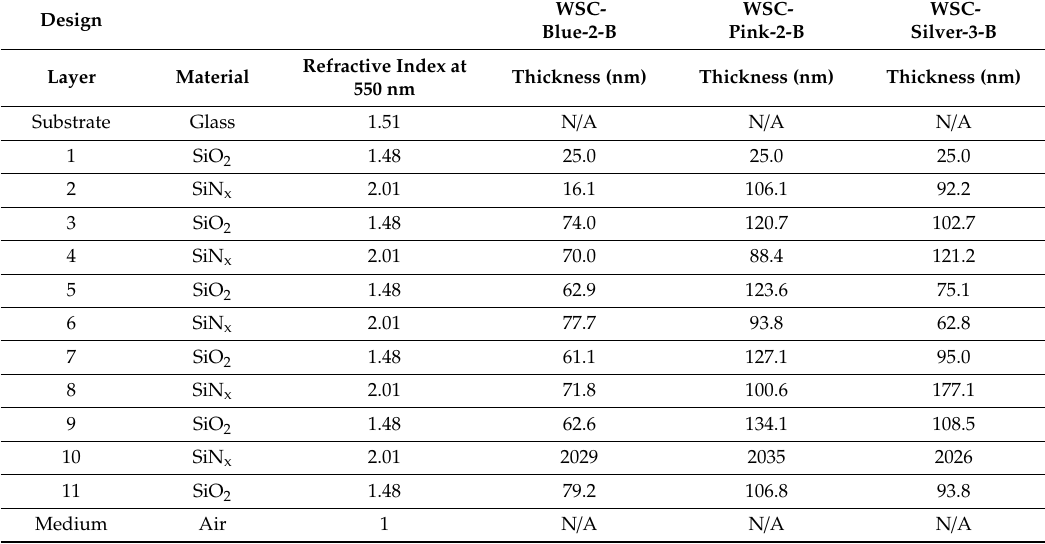
Table A3. Summary of detailed coated designs for Design Strategy 2 samples. The wavelength-selective interference is generated by optical interference layers 1–9, which are buried underneath the thickest hard coating layer